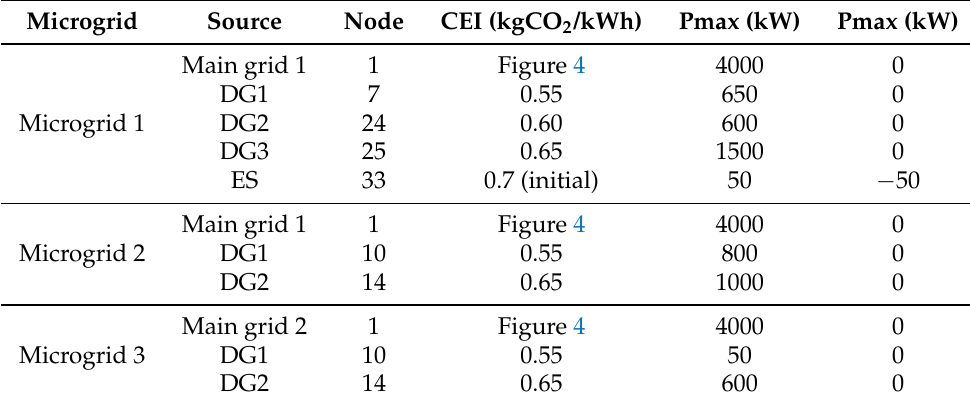
Table 6. Operating parameters of sources in